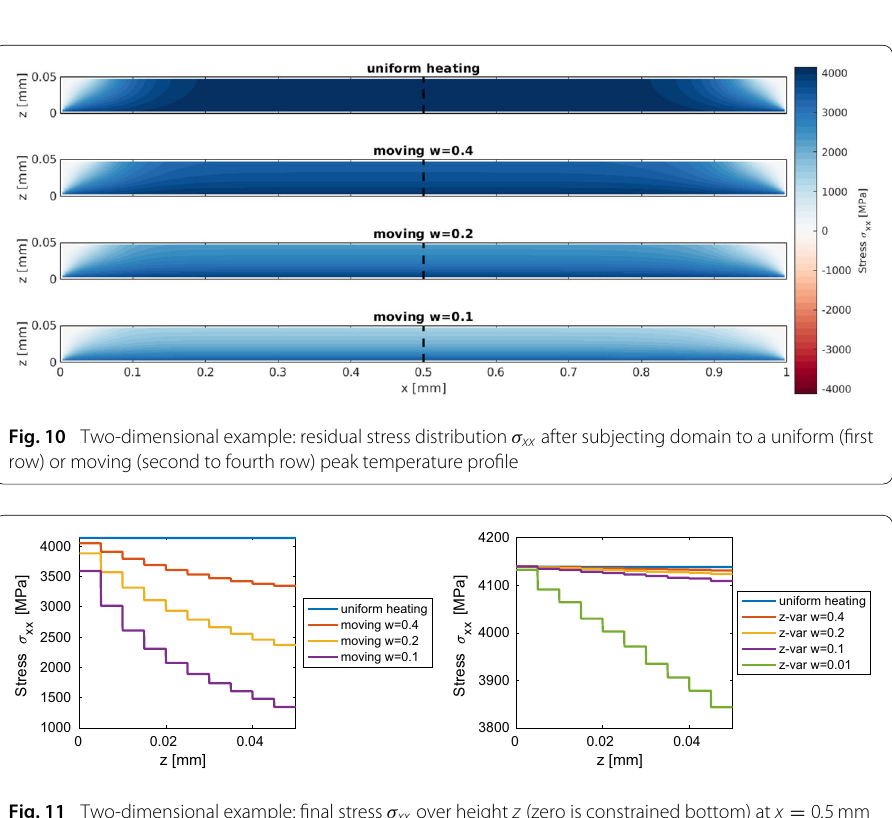
Fig. 11 Two-dimensional example: final stress σ xx over height z (zero is constrained bottom) at x = 0 . 5mm (see dashed line in Fig. 10): induced by a temperature peak moving in x -direction, constant in z -direction (left); induced by a temperature profile varying in z -direction, constant in x -direction (right). Note the different ranges of the